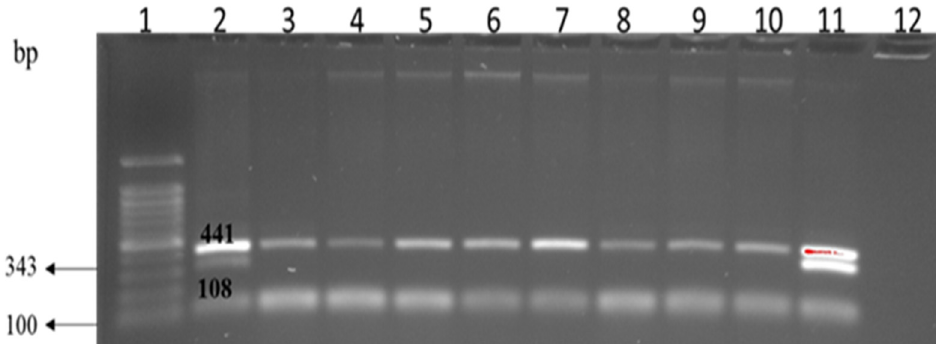
Figure 3. Multiplex PCR amplification of gyr A and rpo B genes in K. pneumoniae and Klebsiella spp. Lane 1: 1 kb ladder; lane 2 & 11: positive control; lane 3–10: K. pneumoniae and Klebsiella spp.; lane 12: negative control.